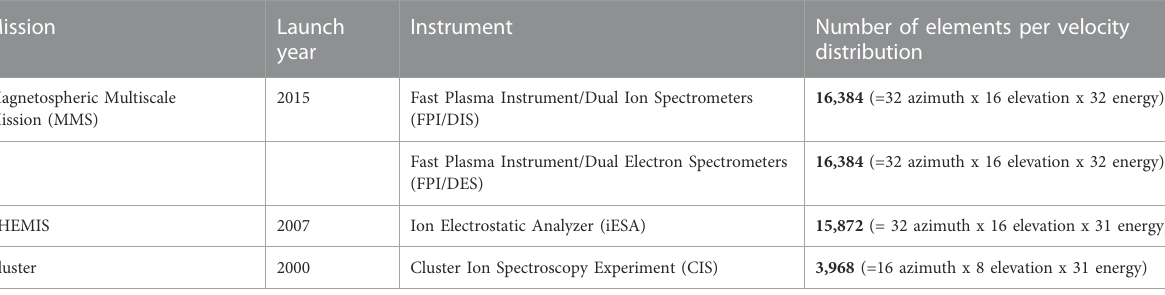
measurements is dominated by the plasma velocity distributions (Table 1). Therefore, to ef fi ciently manage the telemetry reserve for Heliophysics science goals, one should fi rst look at the plasma measurements.